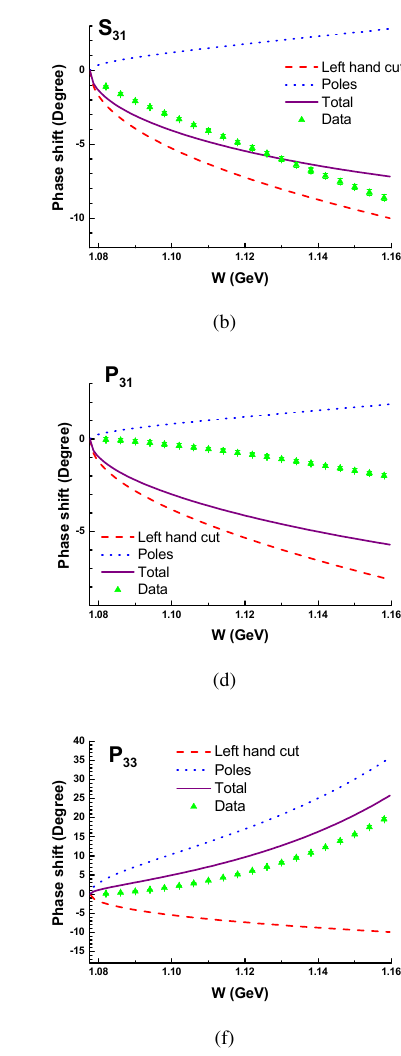
Figure 1. Tree level PKU representation analyses of the π N elastic scattering in S - and P - waves.